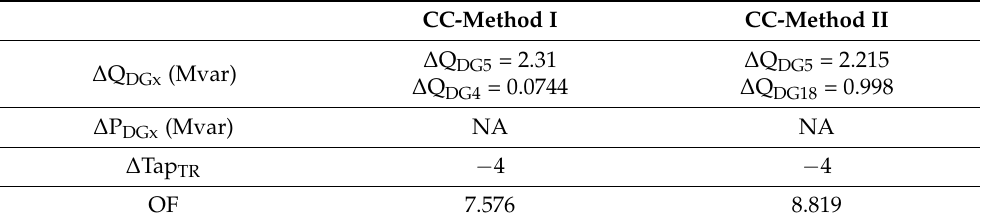
Table 1. Control decisions taken by the proposed CC voltage control framework with (cid:101) = 0.1.